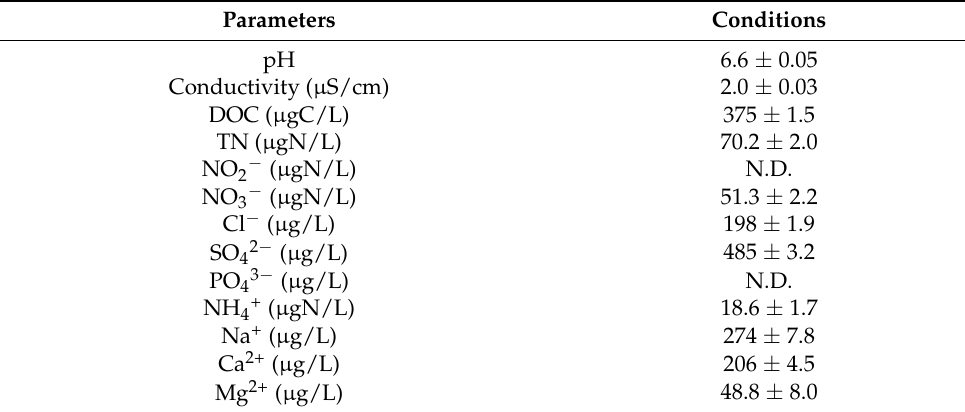
Table 2. Rainwater quality parameters (n = 3).